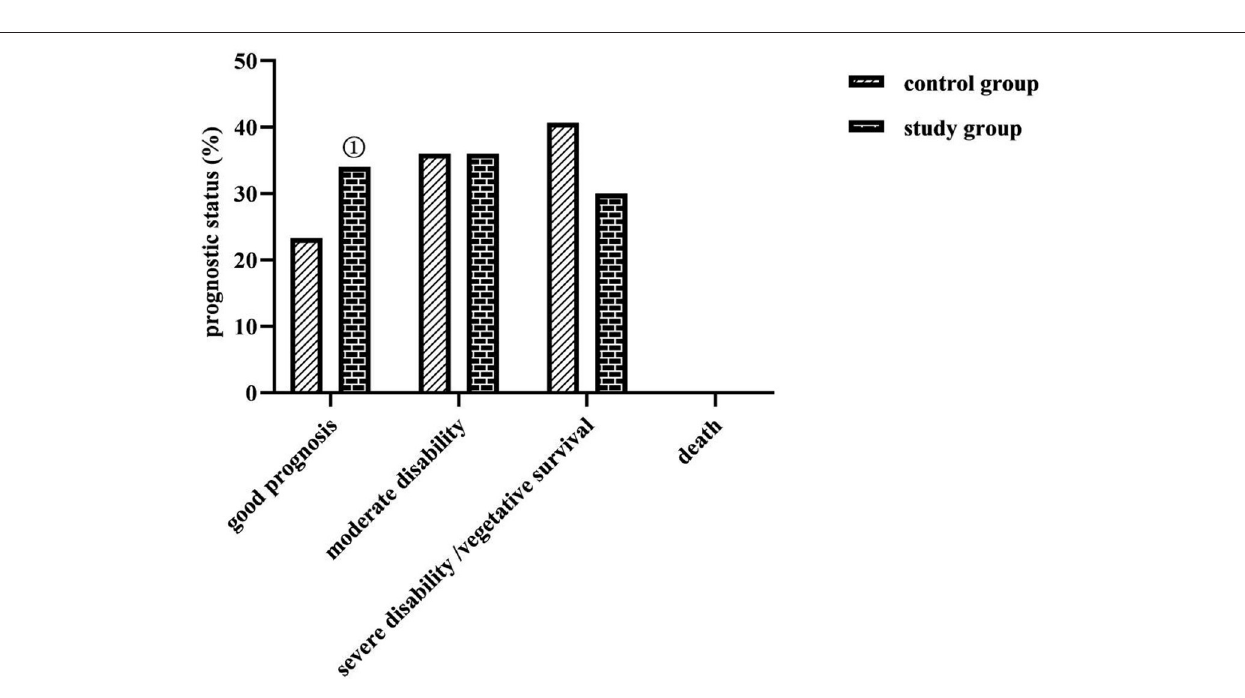
FIGURE 4 | Comparison of prognostic status between the two groups ( n , %). No death prognosis in both groups. Comparison with the control group on the same ‹ P < parameters,